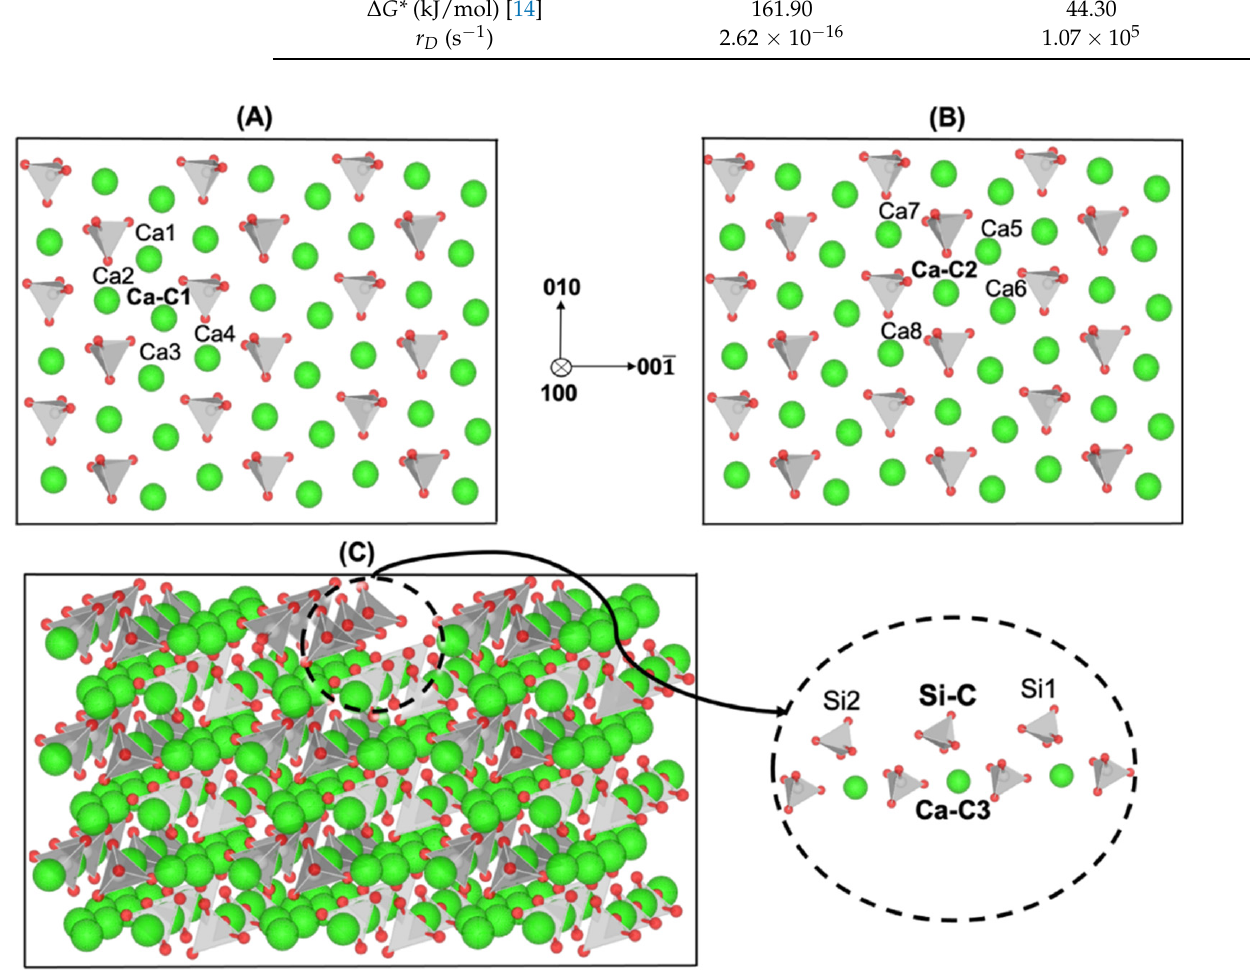
Figure 1. Illustration of four different cases for dissolution of Ca-C1, Ca-C2, Ca-C3, and Si-C depending on the existing nearest neighbors. ( A , B ) The dissolution of Ca , namely Ca-Ca1 and Ca-C2, from the row of Ca depending on the four existing neighbors related to cases 1 and 2, respectively. ( C ) The dissolution of Si-C (case 3) depending on the two silicate neighbors (Si1 and Si2), as well as Ca-C3 dissolution (case 4) depending on the existence of the upper Si atom (Si-C).